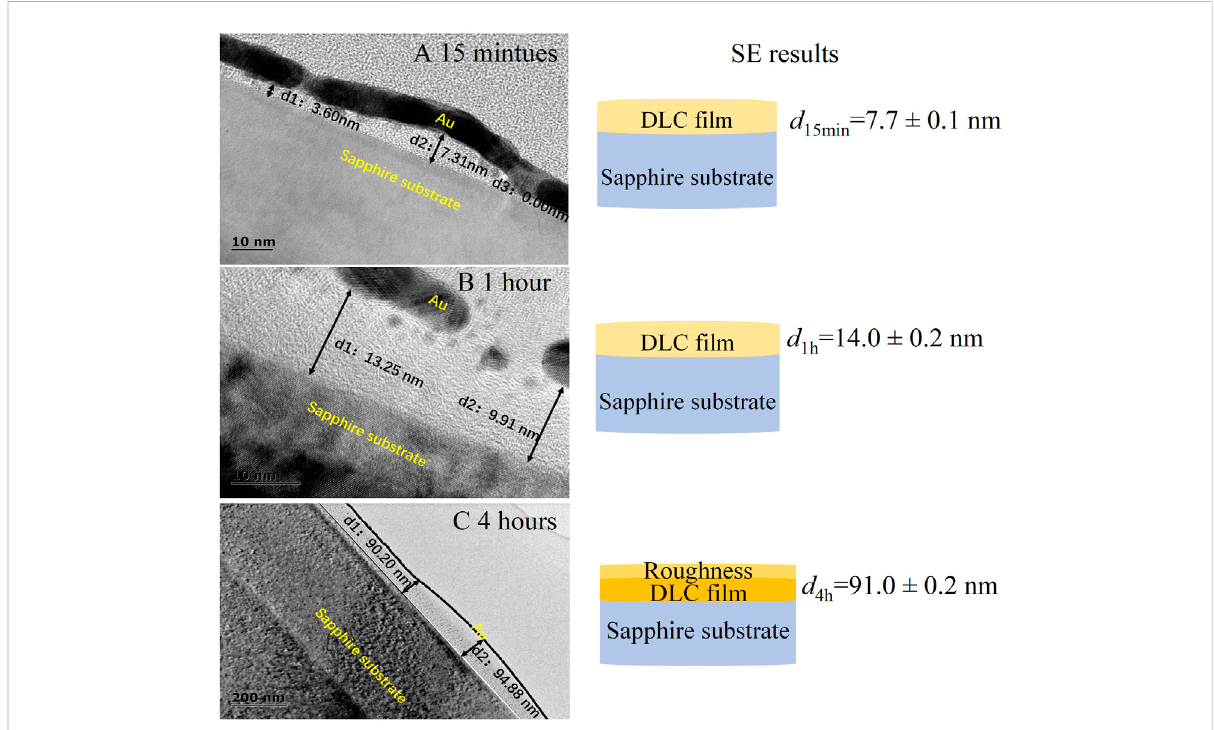
FIGURE 8 FilmthicknesswithdifferentdepositiontimebyTEMcross-sections.Filmdepositionfor15 minsample (A) ,for1 hsample (B) ,for4 hsample (C)